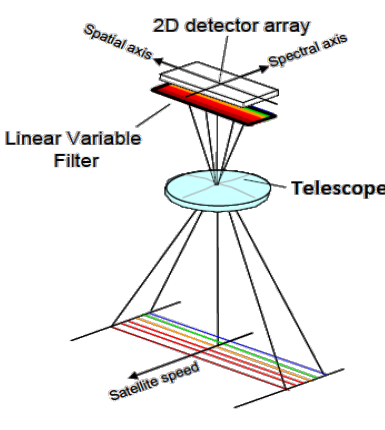
Figure 1: concept of a linear variable filter based spectrometer